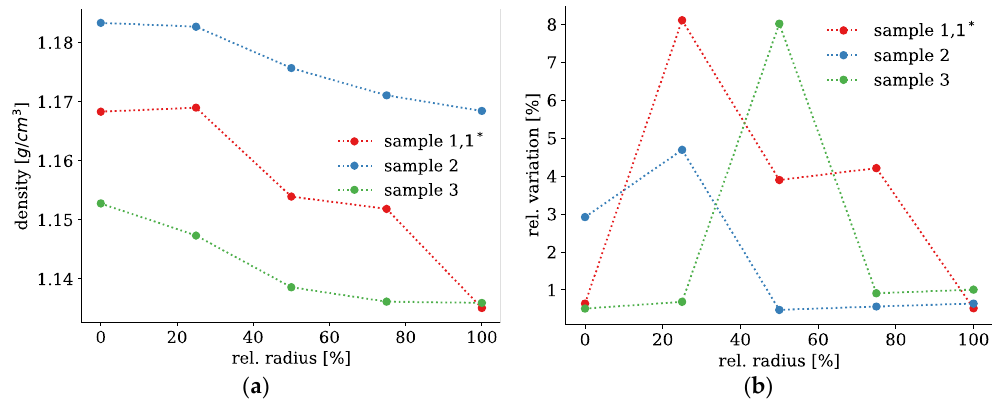
Figure 7. Simulated density profiles over the radius of the investigated samples ( a ). The densities show a clear decrease towards the outer regions. The relative density variation follows no real trend, but sample 2 shows the most homogeneous density ( b ).